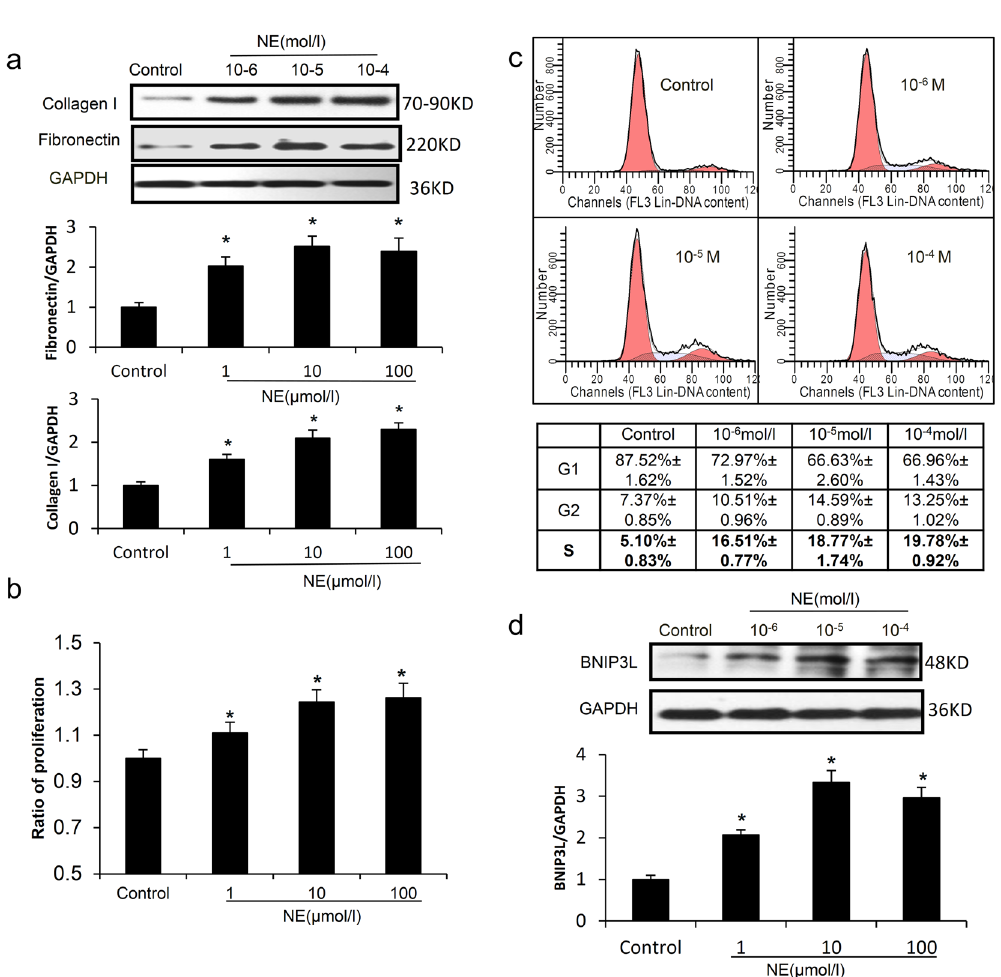
Figure 3. The effects of NE on cell fibrosis and BNIP3L expression in CFs. Neonatal rat CFs were treated with different concentrations of NE for the indicated times. ( a ) Western blot analysis showing NE-induced fibronectin and collagen I expression. ( b ) Proliferation was measured using the MTT assay. ( c ) Cells were stained with PI and examined by FACS. The data were analyzed using the ModFit program. ( d ) Western blot analysis showing NE- induced BNIP3L expression. Each experiment repeated three times. Data shown are mean ± SD, * P < 0.05 vs.